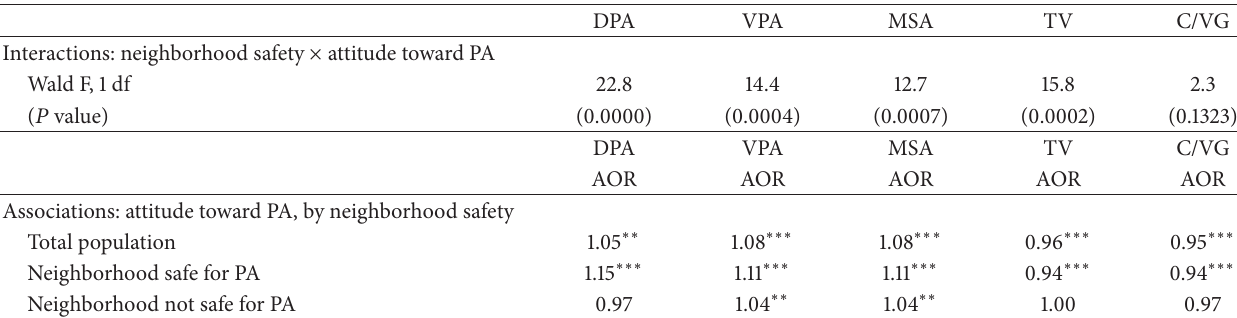
Table 5: Interactions between neighborhood safety and attitude toward physical activity (PA) and associations between PA attitude and participation in PA and sedentary behaviors, by neighborhood safety among US high school